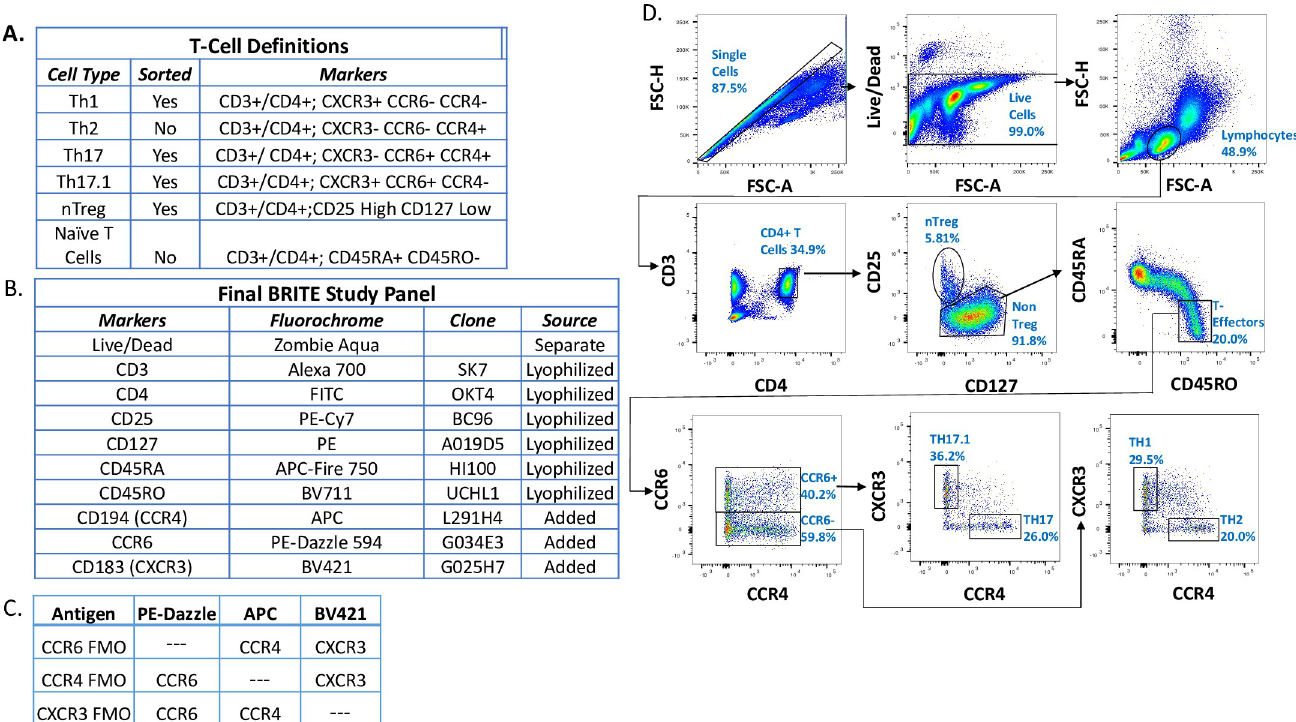
Fig 2. Gating strategy used to differentiate immune cell populations based on cell surface markers. A) Cell surface marker combinations used to identify CD4 + T cell subset populations. B) The final optimized flow panel for separation of cell populations across different sites noting which reagents were in the lyophilized antibody cocktail, added to the antibody cocktail, or stained separately. C) Fluorescence Minus One (FMO) design and addition of antibodies after reconstituting the FMO lyophilized cocktail. D) Gating strategy illustrating strategy for separation of cell populations. Note, in some plots, can’t see the gates because the blue color blends in with the populations; could consider changing the color of the gate for all